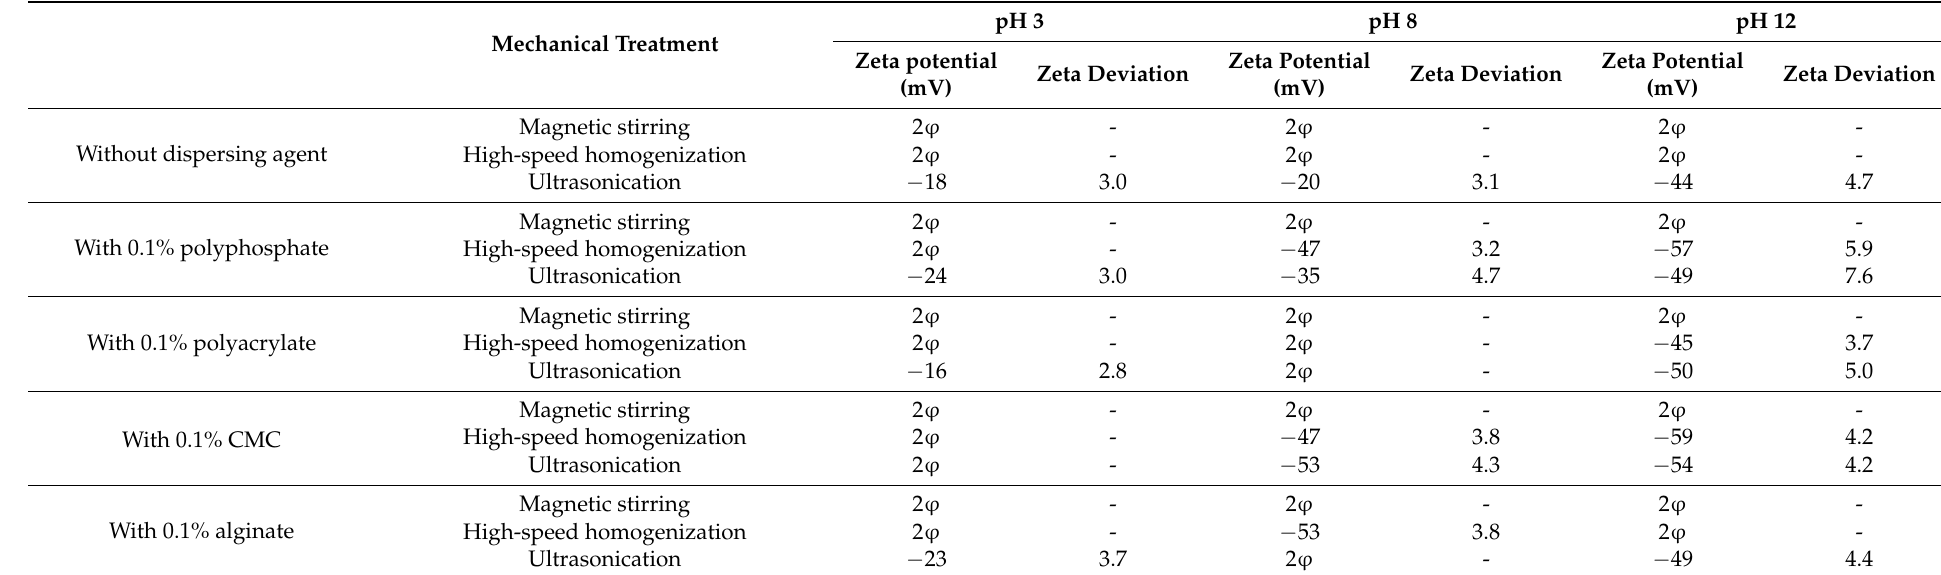
Table 3. Zeta potential values for palygorskite suspensions as a function of the different conditions used.